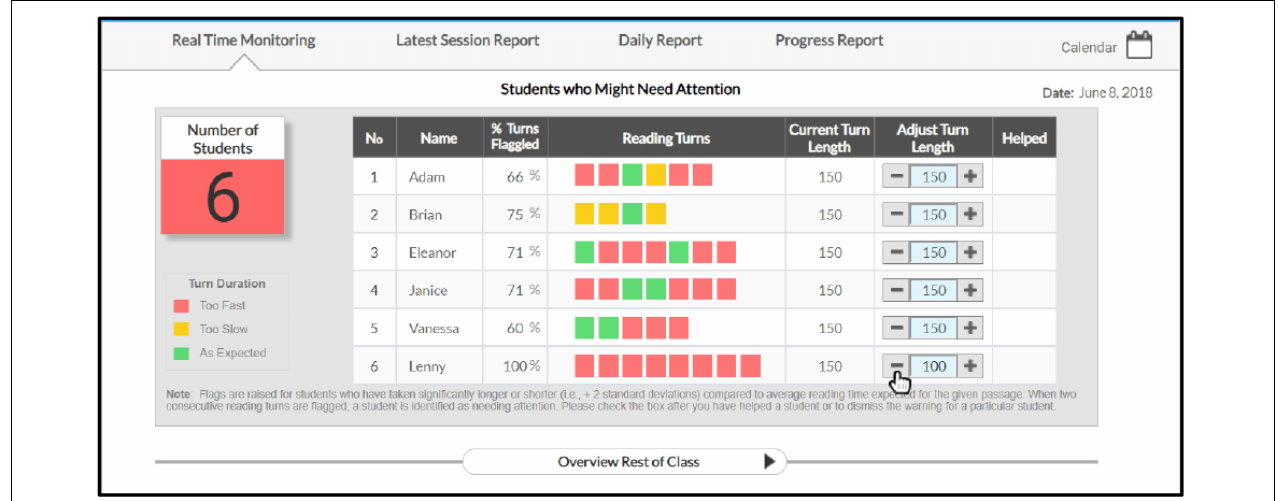
FIGURE 1 | Real time monitoring dashboard example (from Kannan et al., 2019). Shows real-time monitoring of students as they are engaged in a book reading activity (intended for a teacher-facing dashboard for a reading intervention application) to show teachers at-a-glance which students have been staying on task and who may need